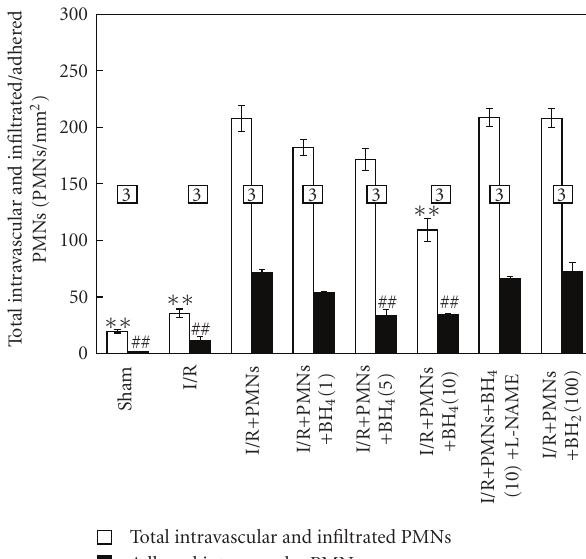
Figure 8: Histological assessment of total intravascular/infiltrated PMNs and vascular adhered PMNs in isolated postreperfused rat heart tissue from di ff erent experimental groups. The total intravascular/infiltrated PMNs in sham, I/R and I/R+PMN+BH 4 (10 μ M) groups were significantly reduced compared to that in I/R+PMN group. Similarly, the vascular adhered PMNs in sham, I/R, I/R+PMN+BH 4 (5 μ M), and I/R+PMN+BH 4 (10 μ M) groups were also significantly reduced compared to that in I/R+PMN group. All values are expressed as mean ± SEM. Numbers of samples are listed in the box with the bars. All drugs are in μ M concentrations. ( ∗∗ P < . 01 from total intravascular/infiltrated PMNs in I/R+PMN group; ## P < . 01 from vascular adhered PMNs in I/R+PMN group).